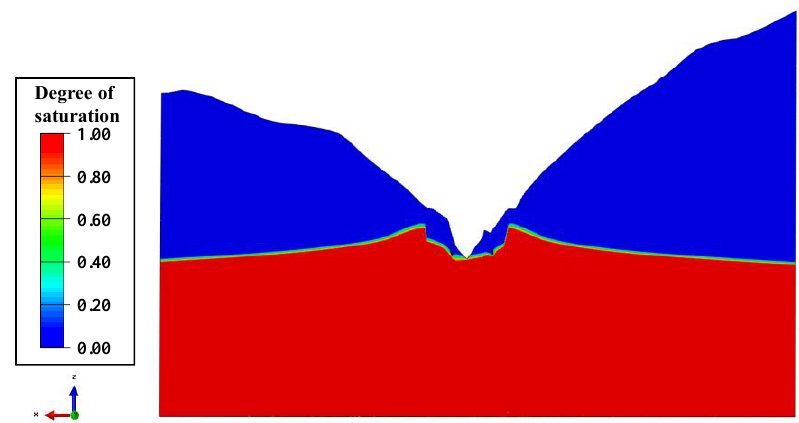
Figure 19. Numerical calculation results of rock-mass saturation at dam site cross-section.